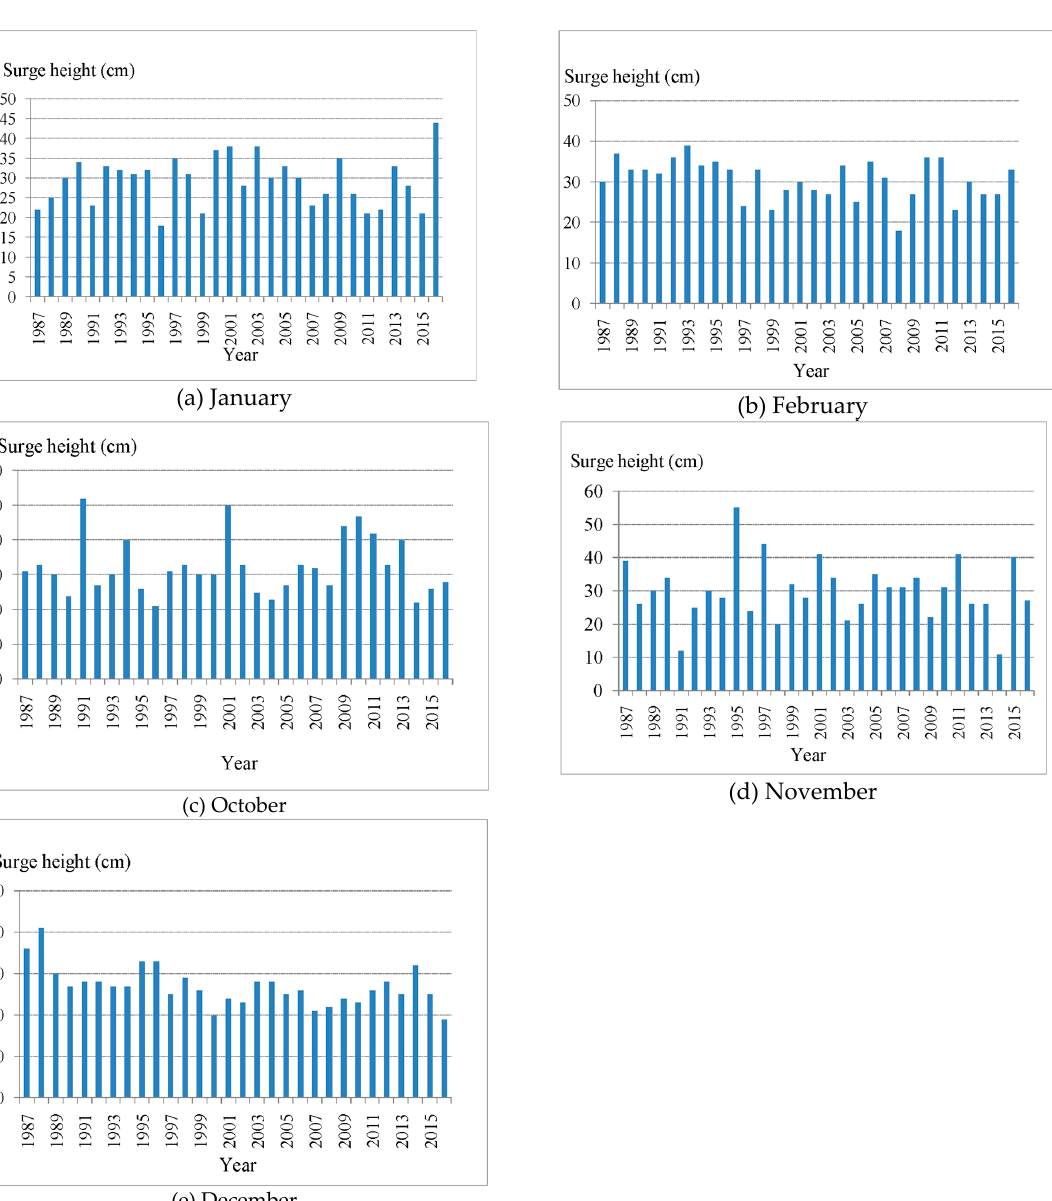
Figure 7. Peak surge heights at Vung Tau station in 1987–2016. (a) January, (b) February, (c) October, Figure 7. Surge heights at Vung Tau station in 1987–2016. ( a ) January, ( b ) February, ( c ) October, (d) November and (e) December ( d ) November and ( e )